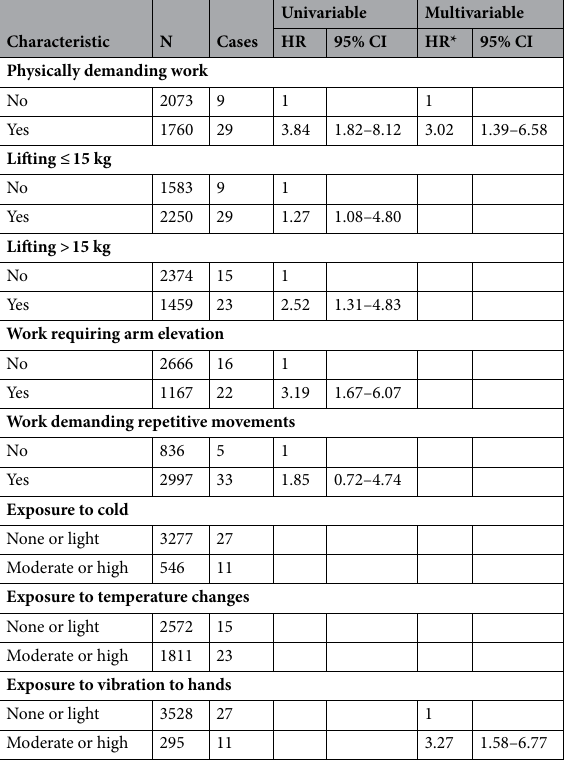
Table 3. Univariable and multivariable hazard ratios (HR) with 95% confidence intervals (CI) of hospitalization for ulnar nerve entrapment in subsample (N = 3833). *Adjusted for variables with P value ≤